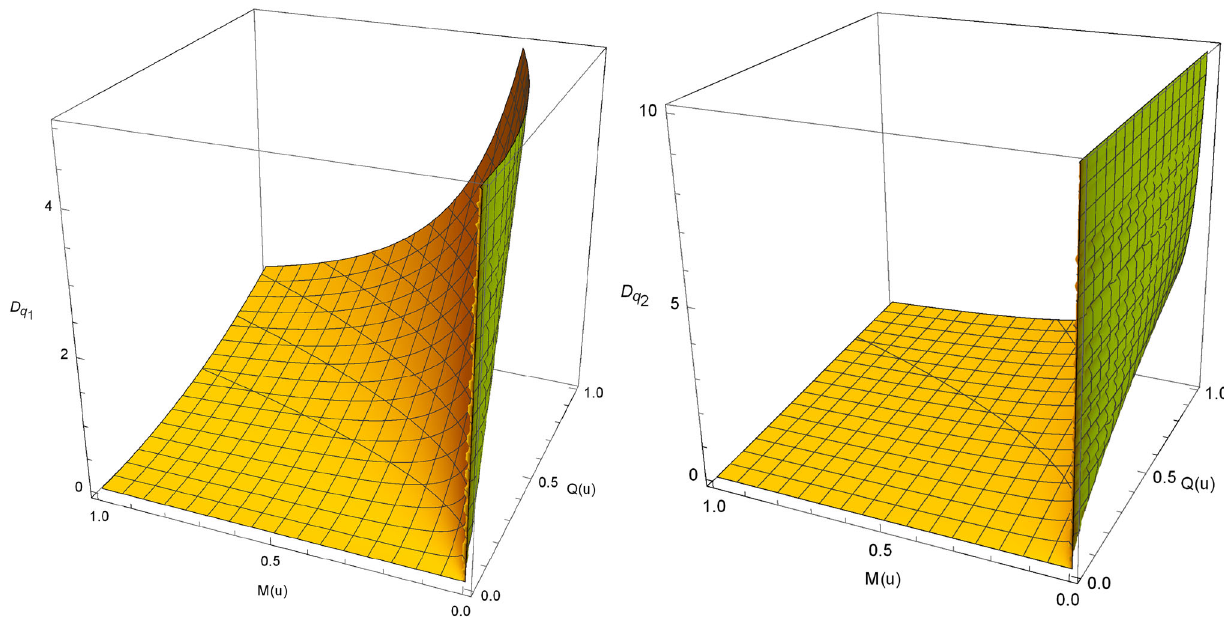
(cid:16) (cid:16) (cid:16) (cid:16) (cid:16) (cid:10) 1 and (cid:16) (cid:10) 1, respectively (cid:16) a q 1 (cid:16) a q 2 a N a L